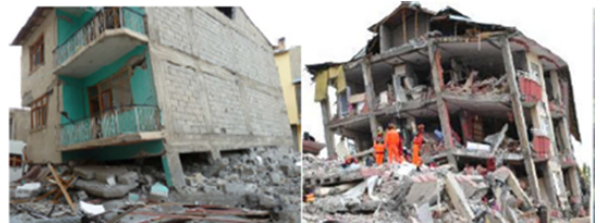
Figure 21. Damage observed in buildings with insufficient lateral rigidity.